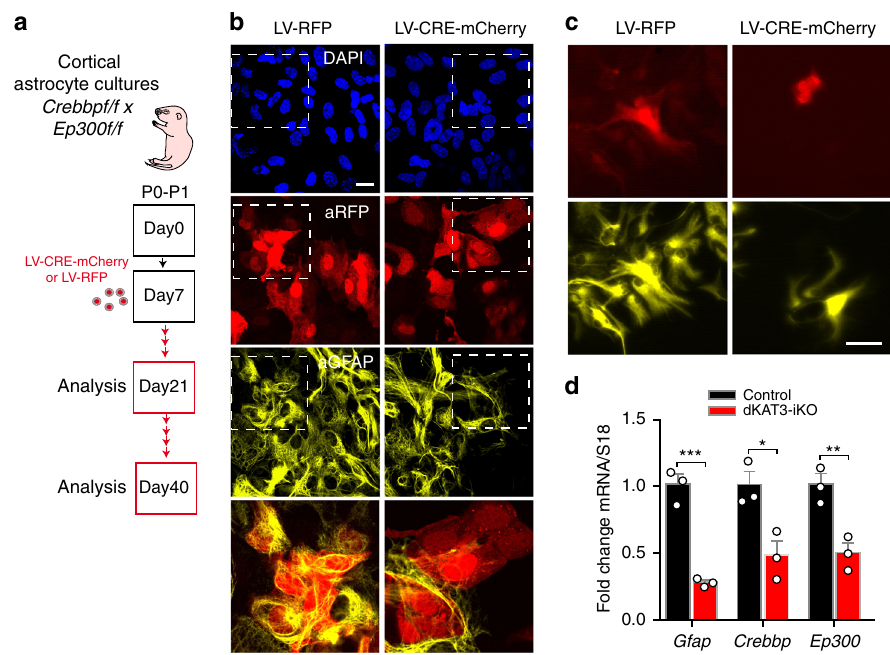
Fig. 6 CBP and p300 are needed to maintain the fate of other cellular types. a Generation of dKAT3-KO astrocytes. Cortical astrocytes from Crebbp f/f :: Ep300 f/f pups were infected with a cre recombinase-expressing LV. b Cultured dKAT3 f/f astrocytes show a downregulation of astrocyte marker GFAP 2 weeks after infection with a cre recombinase-expressing LV ( n = 3 for both groups). Scale bar: 20 μ m. c The loss of astrocyte morphology is more evident 4 weeks after infection (n = 3 for both groups). Scale bar: 50 μ m. d RT-PCR quanti fi cation of the Gfap (GFAP), Crebbp (CBP), and Ep300 (p300) transcript levels in cultured dKAT3 f/f astrocytes ( n = 3). Data are presented as mean values ± SEM. Two-tailed t -test: **** p < 0.0001, *** p < 0.001, ** p < 0.01; * p < 0.05. Source data are provided as a Source data fi